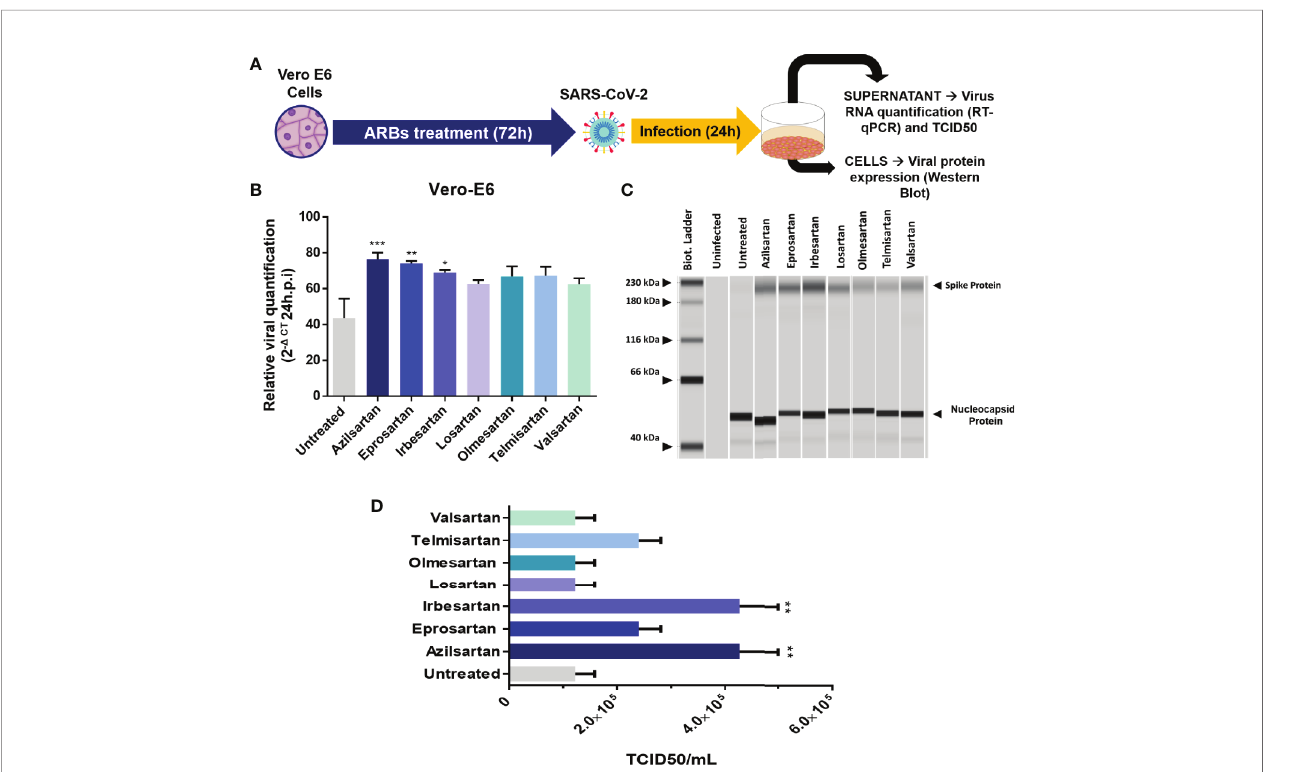
FIGURE 3 | Effects of pre-treating Vero E6 cells in cells with different ARBs on the SARS-CoV-2 production. (A) Schematic fl ow of the analysis: Vero E6 cells were treated with different non-cytotoxic concentrations of ARBs (Azilsartan 15µM; Eprosartan 30µM; Irbesartan 60µM; Losartan 7µM; Olmesartan 15µM; Telmisartan 7µM;